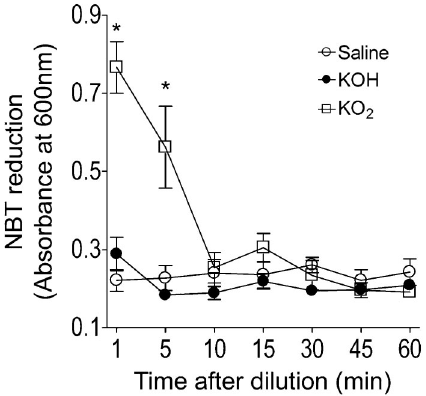
Figure 4. KO 2 dissolution in saline produced superoxide anion. KO 2 (30 m g, 25 m L of saline) or KOH (equimolar concentration to KO 2 , 25 m L of saline) solutions were prepared and mixed with 100 m L of nitrobluetetrazolium (NBT) reagent at the indicated time points. Dataare reportedasmeans±SE.*P , 0.05 vs salinecontrol and KOH solution (one-way ANOVA followed by Tukey’s t -test).